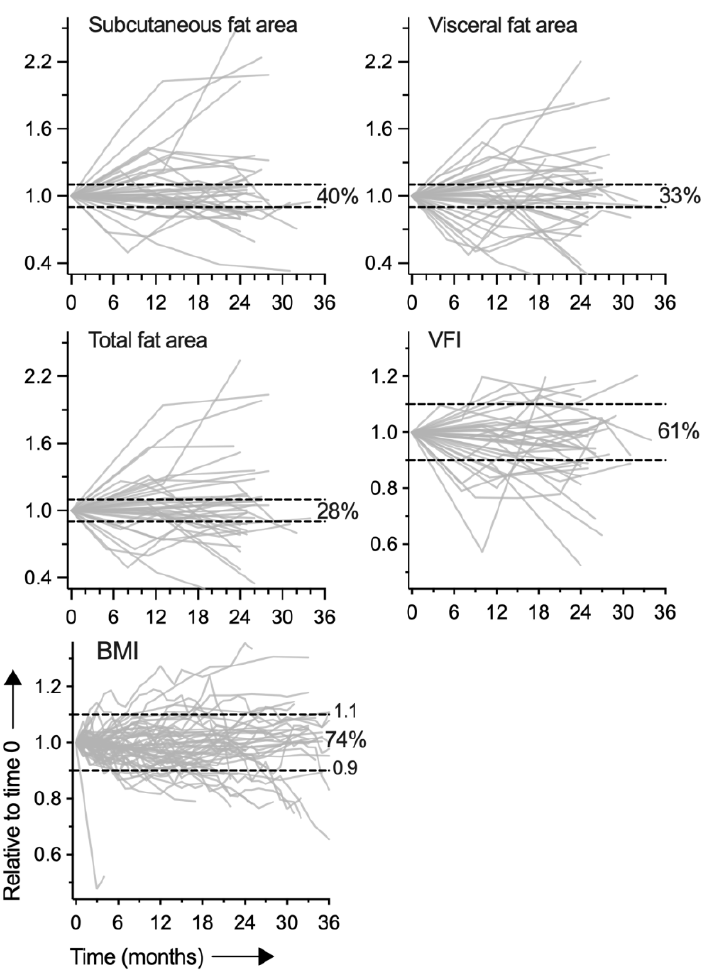
Figure 2. Stability of abdominal fat measures over time. Areas of subcutaneous and visceral ab- dominal fat deposits at the level of L1 vertebra were measured in axial cross-sectional computerized tomography (CT) images of 37 non-small cell lung cancer patients of the study cohort. For each patient, the CT scans were from three to six different time-points that spanned up to three years. Similar time series data (3 to 36 time-points) were obtained for body mass index (BMI) for a separate subset of the cohort (n = 70). Plots show tracks of the fat measures over time for each patient. The fractions of later time-point values that are within 10% of the value at time 0 are noted. Visceral fat index (VFI) was defined as the ratio of visceral to the sum of subcutaneous and visceral fat tissue areas.